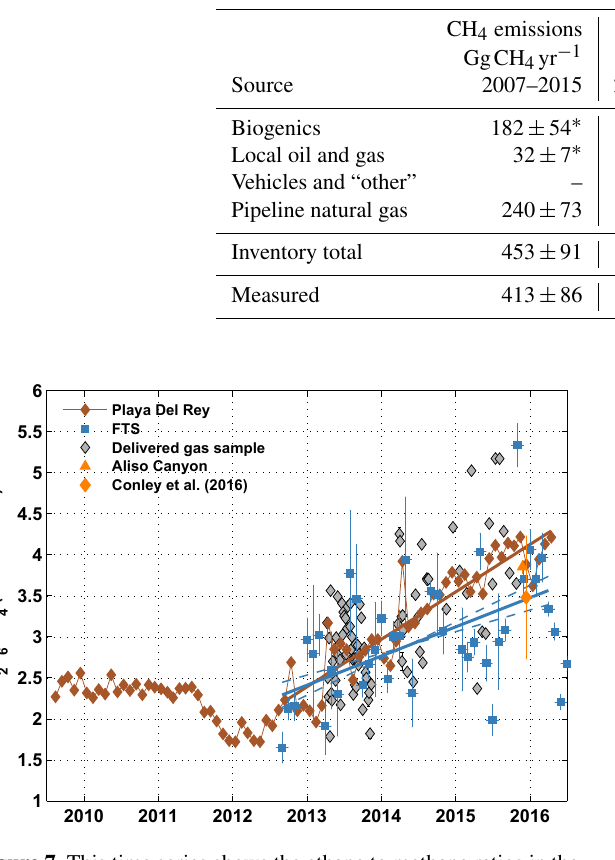
Figure 7. This time series shows the ethane to methane ratios in the Playa Del Rey gas storage facility (brown diamonds), in the natural gas delivered to the laboratory (grey diamonds), and in gas anoma- lies measured with the Caltech FTS (blue squares). The slope of the Playa Del Rey ratios is shown in brown; the slope of the Caltech FTS ratios is in blue with dashed lines indicating the slope uncer- tainty. The slope of the delivered gas samples is not shown, but it is statistically indistinguishable from the Playa Del Rey slope. The median ethane to methane anomaly ratio measured by SoCalGas in the air near the Aliso Canyon gas leak is indicated by the orange tri- angle, and the value near Aliso Canyon measured from an aircraft platform by Conley et al. (2016) is indicated by the orange